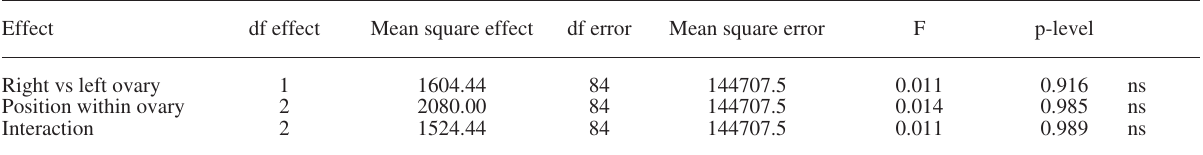
Table 4. – Two-way ANOVA of No. eggs/g of ovary tissue in hake. Effect of the position of ovarian tissue samples on the number of hydrated eggs per unit sample weight (g). Positions of the sample were anterior, middle and posterior of ovarian lobes. ns = not significant